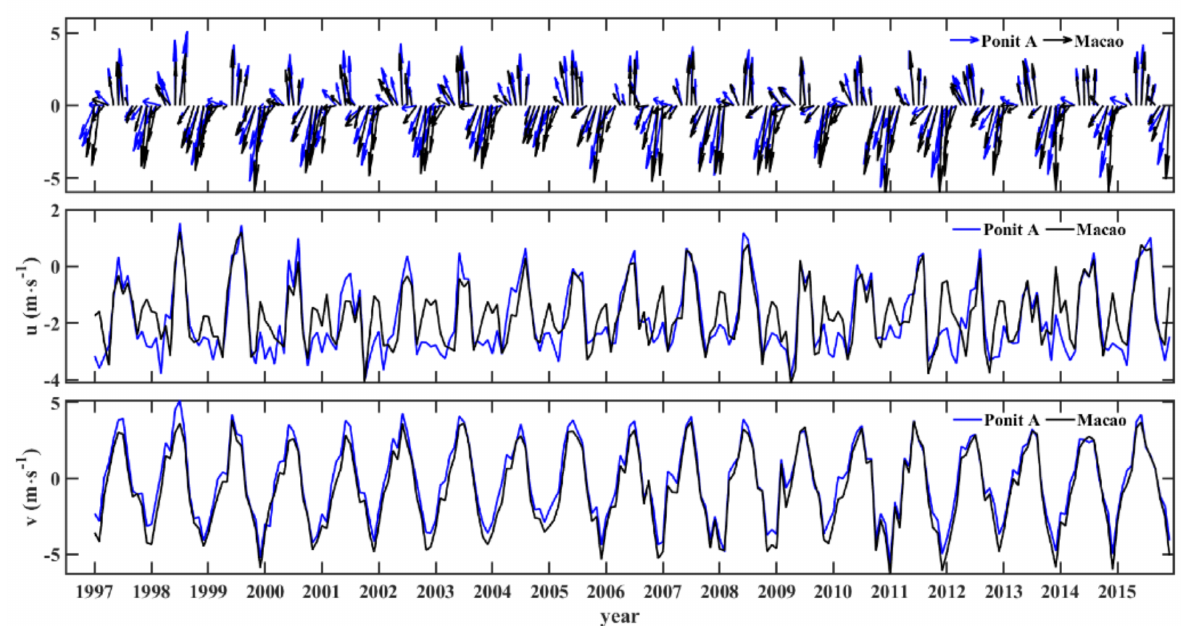
Figure 4. Comparisons of monthly mean wind vectors ( upper ), u-component ( middle ) and v-component ( lower ) of wind data from 1997 to 2015 obtained from ERA5 data at station A (blue) and observation data at Macao Airport (black). The location of station A is in the lower PRE and close to Macao Airport.